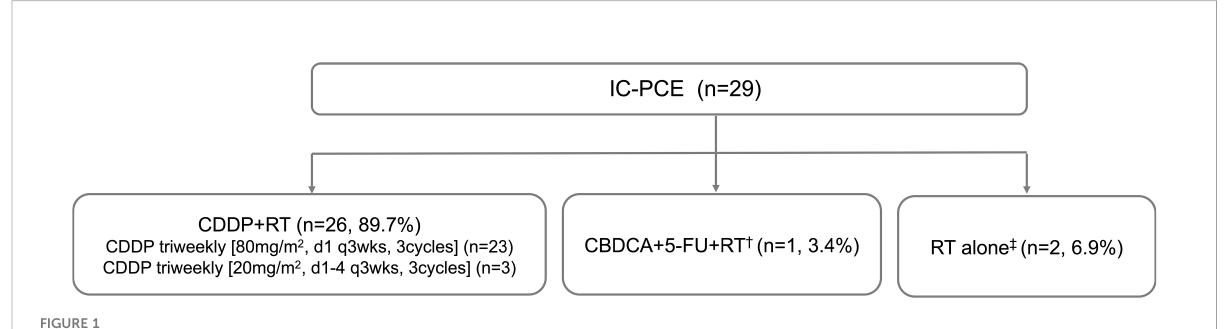
FIGURE 1 Patient fl ow diagram of treatment delivery. IC, induction chemotherapy; CDDP, cisplatin; RT, radiotherapy; CBDCA, carboplatin; FU, fl uorouracil. † Ineligible for CDDP because of decreased ejection fraction. ‡ Originally planned to receive CDDP+RT but CDDP could not be administered due to tumor infection or